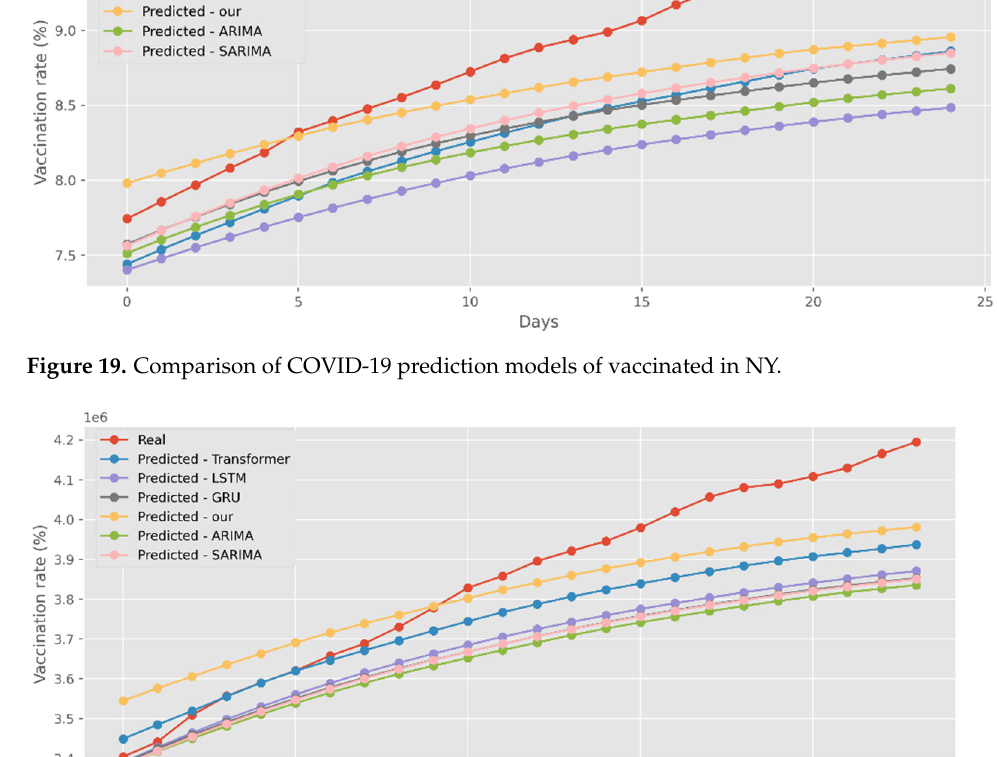
Figure 20. Comparison of COVID ‐ 19 prediction models of vaccinated in VA.